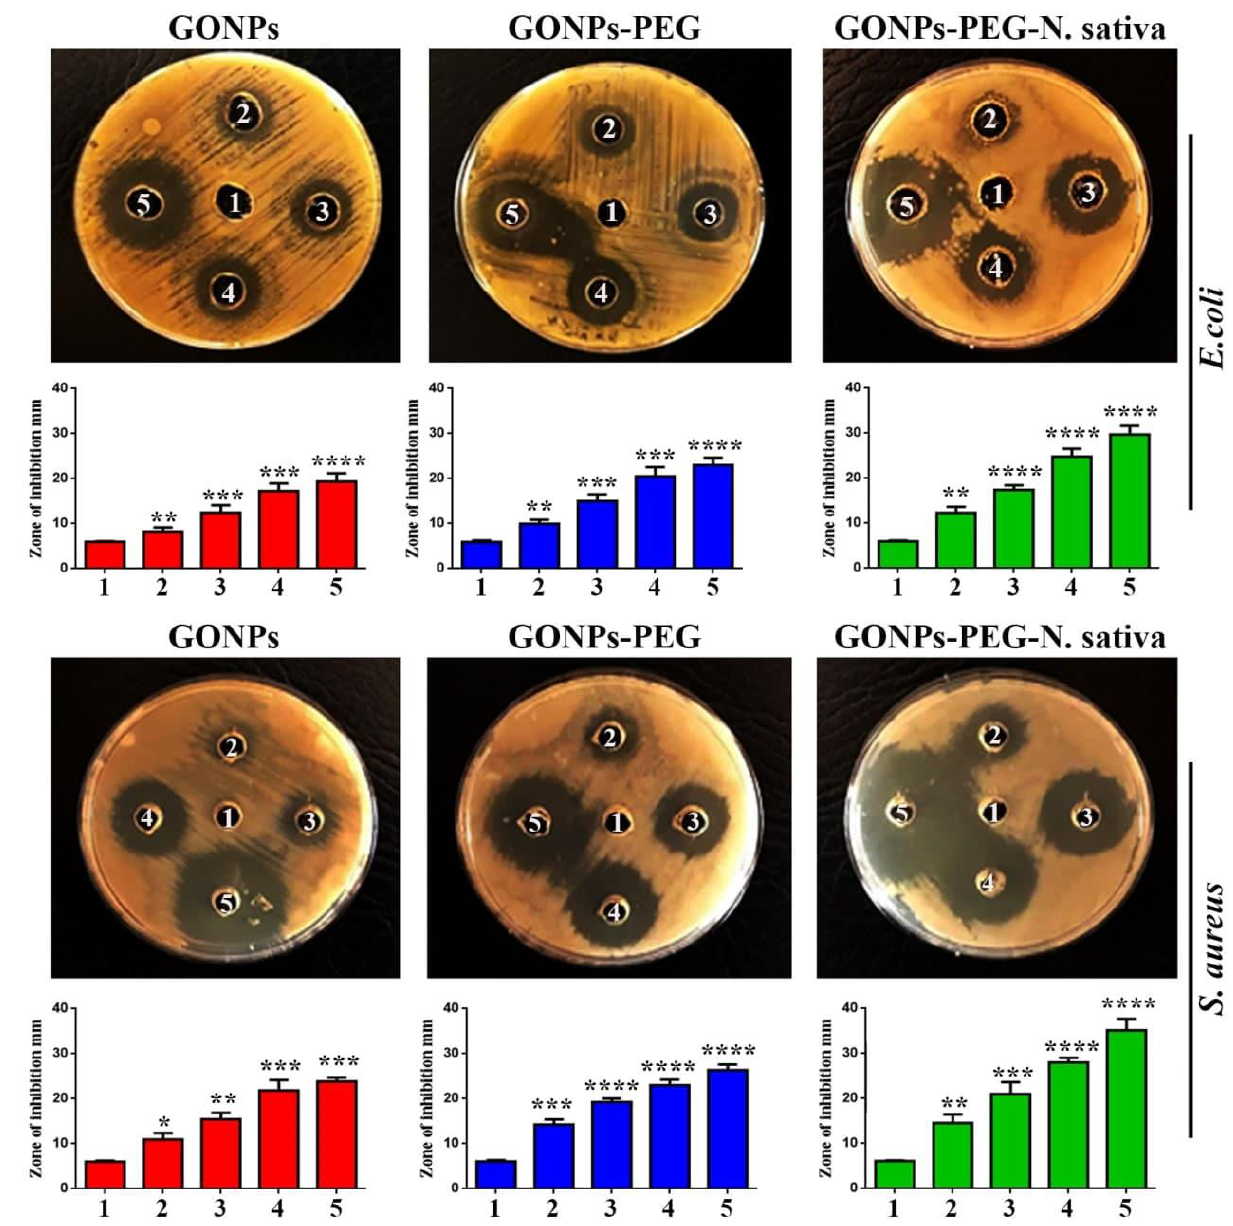
Figure 7. Anti-bacterial activity of GONPs, GONPs–PEG, and GONPs–PEG– N.sativa against S.aureus and E.coli. (1): control untreated bacterial strains. The inhibited zones of bacterial growth for both strains are illustrated when exposed to variety concentrations as follows; (2): 62.25 µg/mL, (3): 125 µg/mL, (4): 250 µg/mL, (5): 500 µg/mL. The data are shown as the mean ± SD. * p < 0.05, ** p < 0.01, *** p < 0.001, and **** p <